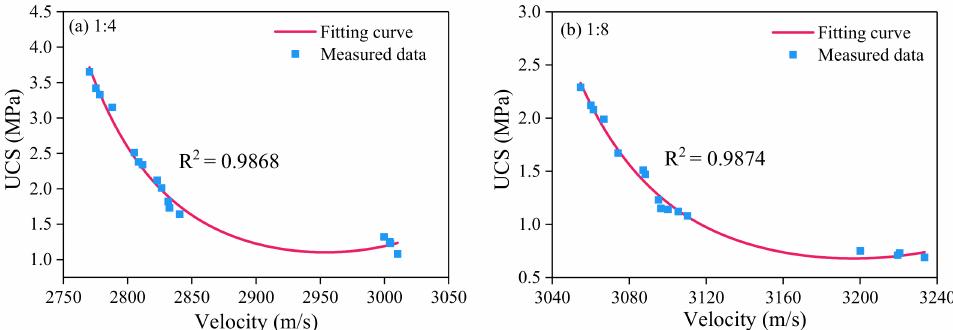
Figure 9. Relationship between UCS and velocity data for different cement-tailings ratio. Quantifica- tion of UCS by wave velocity.